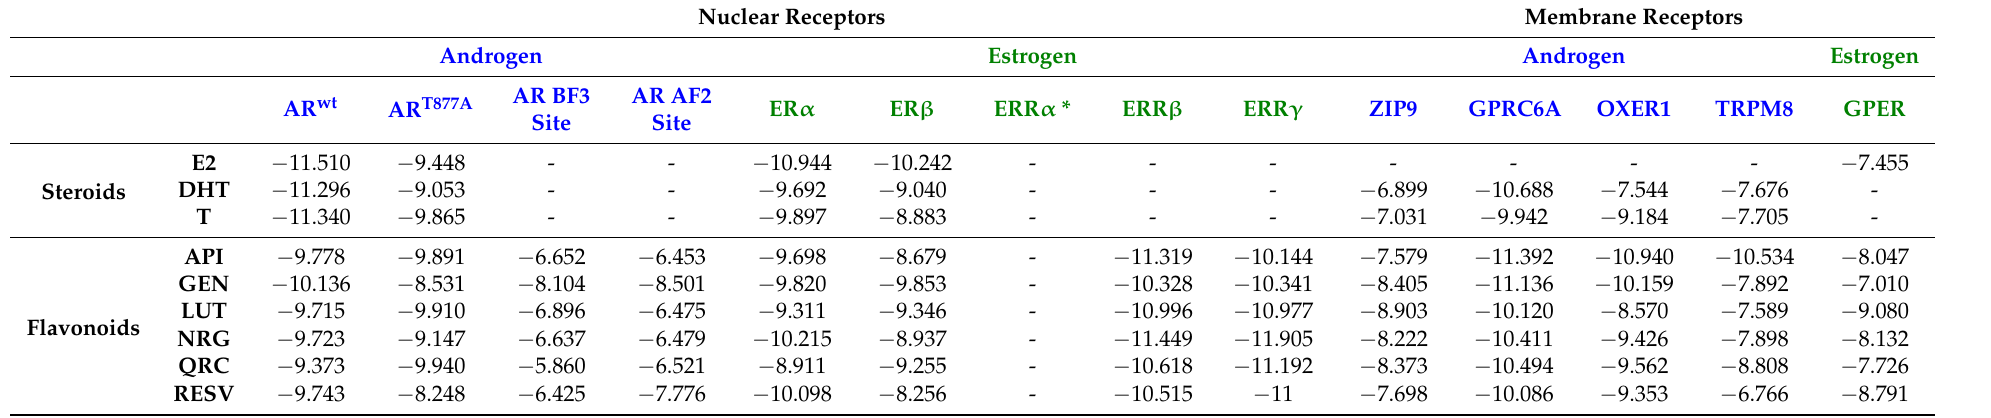
Table 1. Docking scores for the investigated flavonoids and steroids in nuclear and membrane receptors. Nuclear Receptors Membrane Receptors